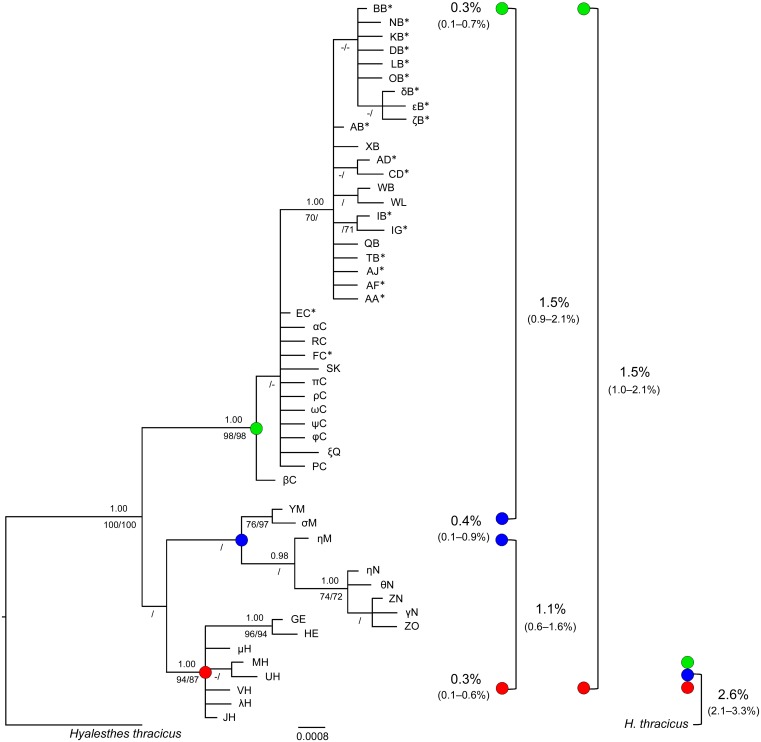
Bayesian phylogenetic tree inferred from 1180 bp of the COI-tRNA(Leu)-COII and 16S-tRNA(Leu)-ND1 concatenated mitochondrial gene regions sampled from the Hyalesthes obsoletus host-associated populations in this and previous studies.The Bayesian posterior probabilities are noted above branches, and the maximum parsimony and neighbor-joining bootstrap support values appear below the branches in that order. Bootstrap values below 70% and posterior probabilities below 0.95 are omitted. The nonrecovered nodes are marked with an em dash "–". The main nodes are designated with colored circles corresponding to host-plant associated haplogroups as follows: green = Convolvulus arvensis and Urtica dioica, blue = Vitex agnus-castus, and red = Crepis foetida. Average within-group genetic distances for each of the three host-plant clusters are noted left of the corresponding colored circle, while between-group distances are given on the right. The range of within- and between-group distances is given in parentheses. Distances are calculated with correction by applying the HKY+I nucleotide substitution model (Hasegawa-Kishino-Yano, pinvar = 0.881) among three genotype groups for all 51 haplotypes according to the three major host-associated clusters; therefore, the Israeli GE and HE haplotypes are considered as Crepis foetida-cluster members, while the QB, ψC and PC collected on crop plant are members of the Convolvulus-Urtica group. Distances between each H. obsoletus host-associated haplogroup and H. thracicus used as the outgroup are presented in the figure’s bottom right corner. Haplotypes detected in previous studies [8, 11, 15, 37] are marked with an asterisk (*).